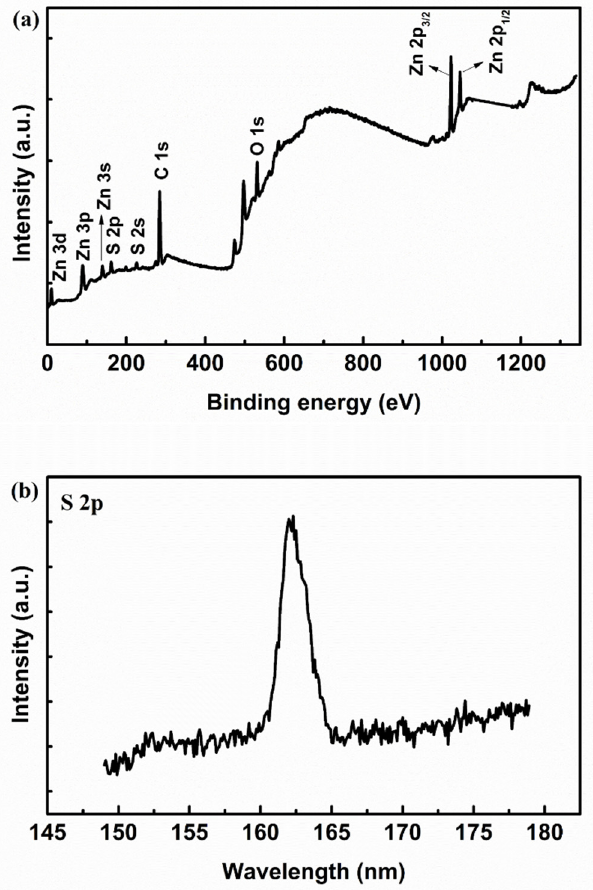
Figure 2. ( a ) XPS wide-survey spectrum; ( b ) S peak of ZnS/ZnO nanocomposites with the immersion time of 30 min.